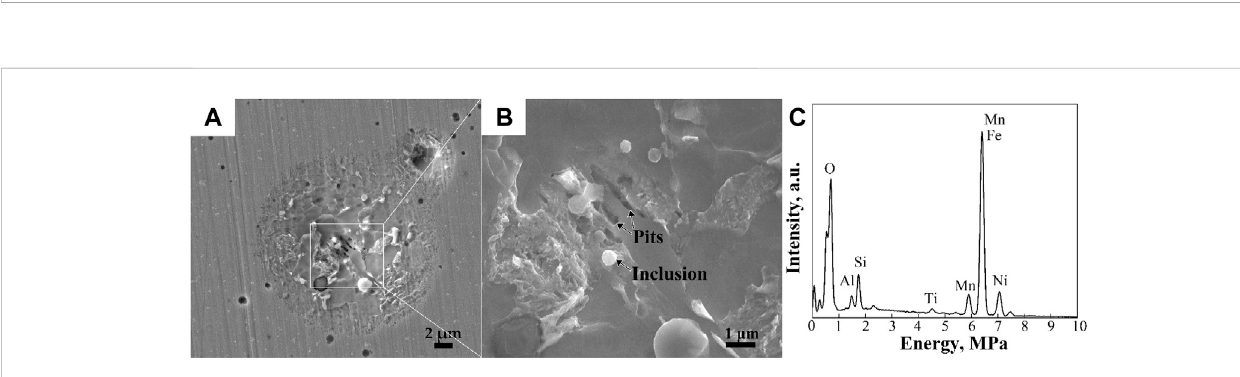
Figure 12. The inclusions, as the cores of corrosion pits, were identi fi ed